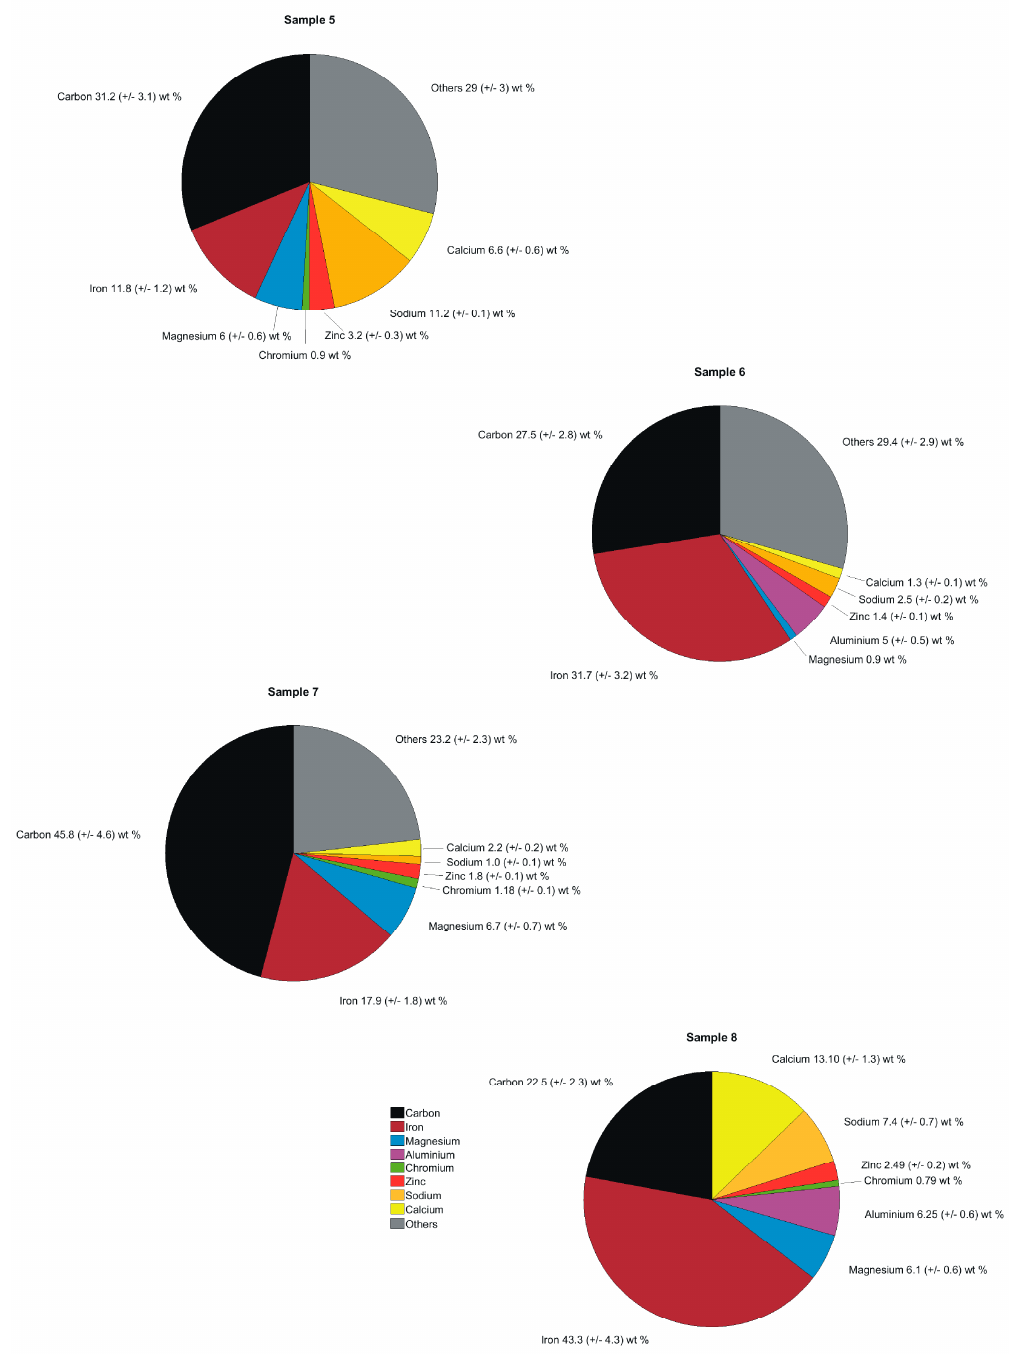
Figure 7. Quantitative determination of selected major chemical elements measured by LIBS, showing average values of wt% in different DPM matrices, (Sample 5, 6, 7 and 8) obtained from in-use passenger diesel combustion engine vehicles.